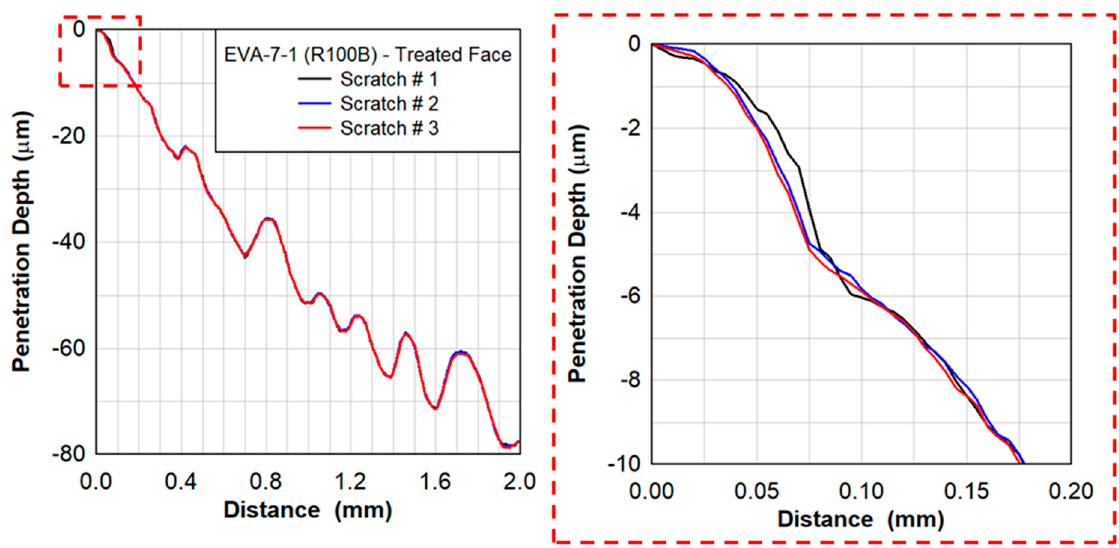
Figure 14. Scratch testing of EVA − 7 − 1 showing the penetration depth as a function of the distance with a scratch rate of 4 mm/min.